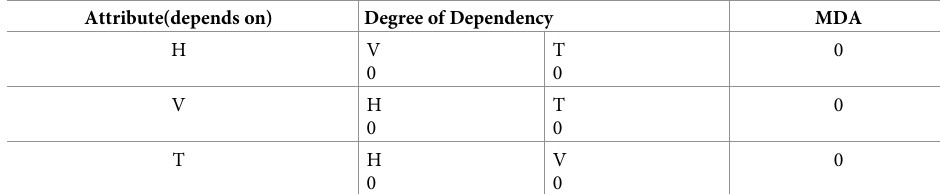
Table 5. Dependency degree of attributes from Table 4.